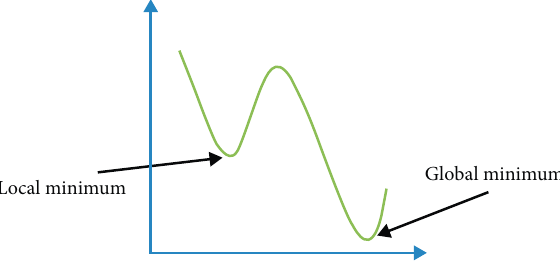
Figure 1: Global minimum and local